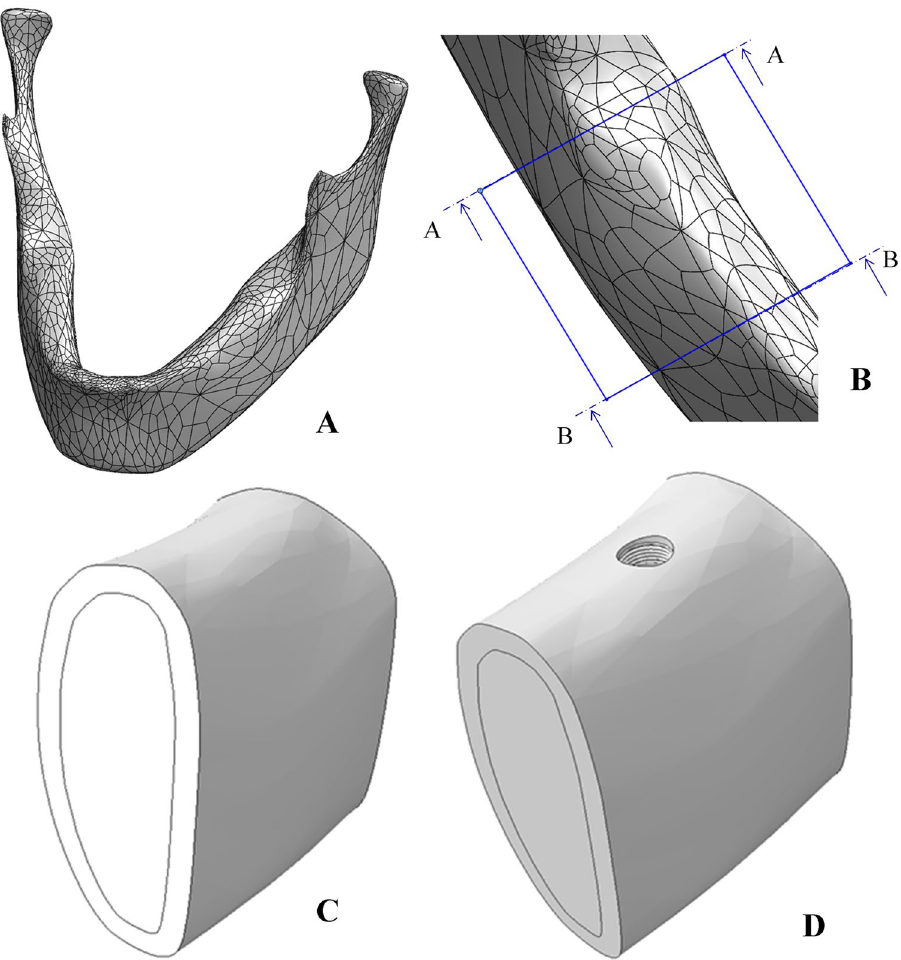
Figure 5. ( A ) Full model of the scanned mandible. ( B ) Cut section of the mandible between the left first and third molars. ( C ) Sectioning the cut bone into cortical and cancellous bone. ( D ) The mandible bone section after implant insertion.